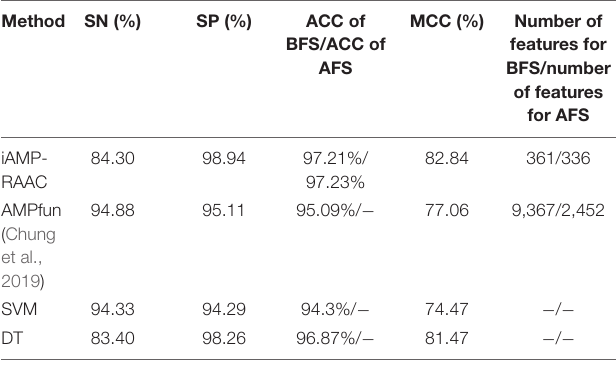
TABLE 3 | Performance comparisons of iAMP-RAAC and the other three methods on training set in DS1 based on 10-fold cross-validation. Method SN (%)